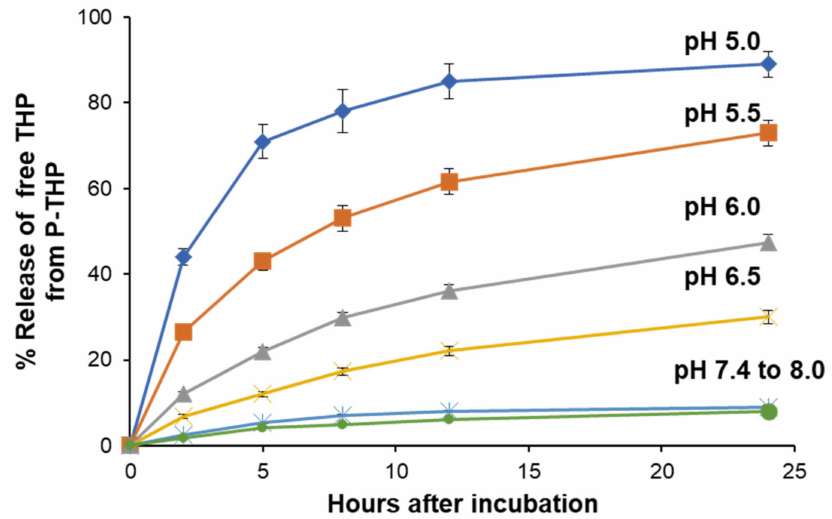
Figure 5. Release profile of free pirarubicin (THP) from the polymer conjugate (P-THP) at 37 ◦ C. P-THP was dissolved in buffer solutions with different pH. The release of THP was determined by HPLC. Adapted from reference